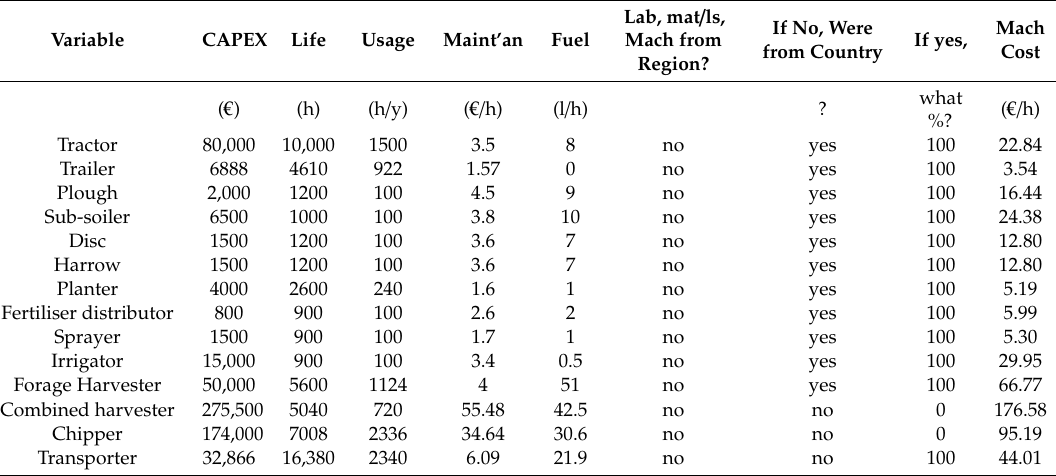
Table A5. Farm machinery costs.